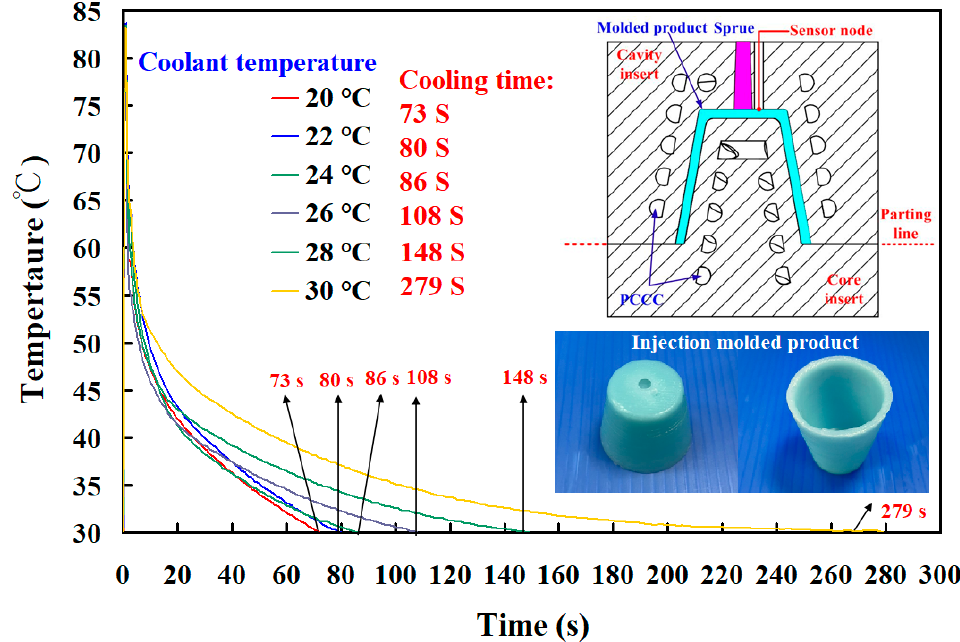
Figure 22. Cooling time of the wax pattern fabricated with epoxy resin added with 39 vol.% Al